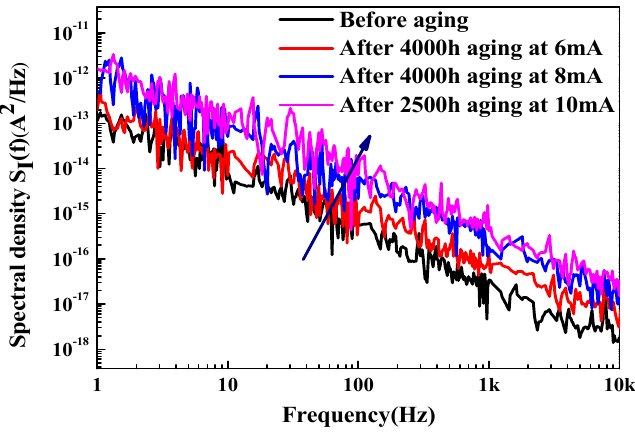
Figure 5. The current noise power spectral density curve of the VCSEL before and after aging.